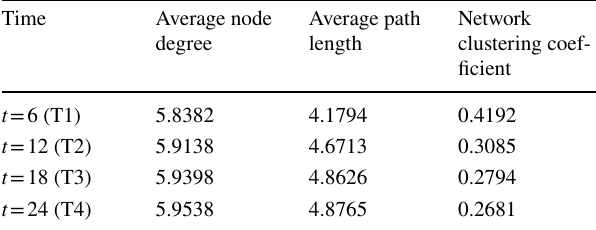
Fig. 9 Evolution process of the logistics network in the Chengdu–Chongqing region Table 5 Characteristic parameters of the regional logistics network in different periods